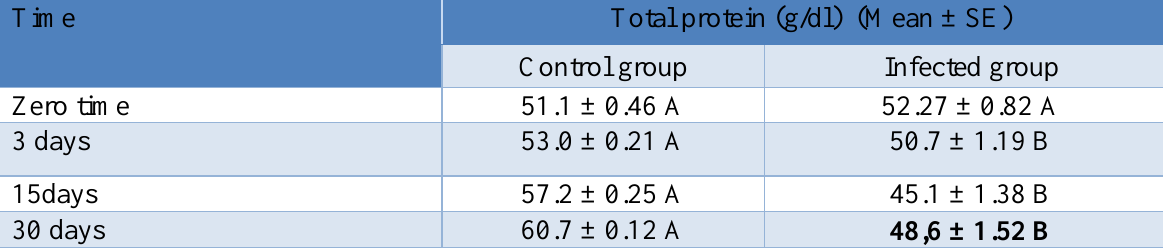
*Different letters A and B horizontally refers to presence of significant differences at (P< 0.05). Table, 7: Effect of E.coli infection on total protein value of infected group compared with control group at zero time, 3,15 and 30 days post